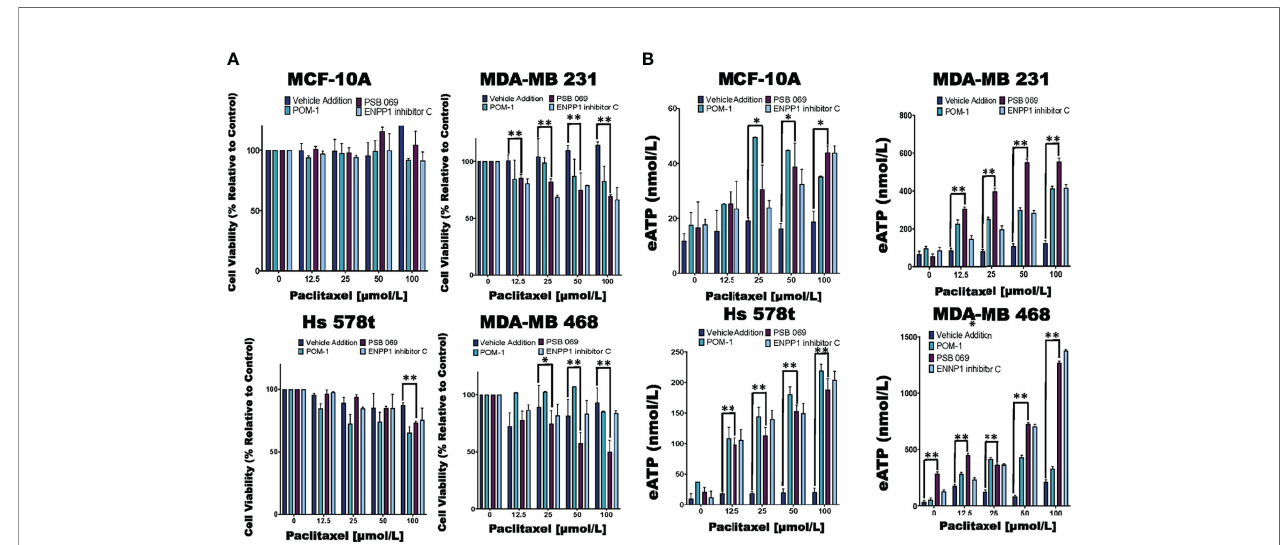
FIGURE 3 | Comparing eATP release from paclitaxel-treated cells in the presence of inhibitors or vehicle addition. (A) TNBC and MCF-10A cells were treated with increasing concentrations of paclitaxel and the nucleoside phosphohydrolase inhibitors POM-1 (E-NTPDase inhibitor, 10 µmol/L), PSB 069 (E-NTPDase inhibitor, 10 µmol/L), ENNP1 inhibitor C (ENPP1 inhibitor, 10 µmol/L) or vehicle addition for six hours, and cell viability was measured using the PrestoBlue HS assay. Standard deviation was calculated from three independent experiments performed in triplicate. (B) eATP concentrations were measured in the supernatants of TNBC and MCF-10A cells after six hours of treatment with increasing concentrations of paclitaxel and nucleoside phosphohydrolase inhibitors or vehicle addition. Standard deviation was calculated from three independent experiments performed in triplicate. One way ANOVA with Tukey ’ s HSD was applied to ascertain signi fi cance. * represents p < 0.05 and ** represents p < 0.01 when comparing vehicle addition to PSB 069. We highlighted just the signi fi cance in the presence of PSB 069 because the cell viability results were consistently signi fi cant.